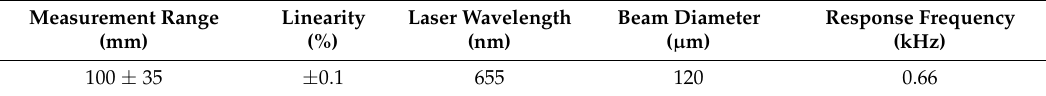
Table 1. Main parameters of the laser displacement sensor.